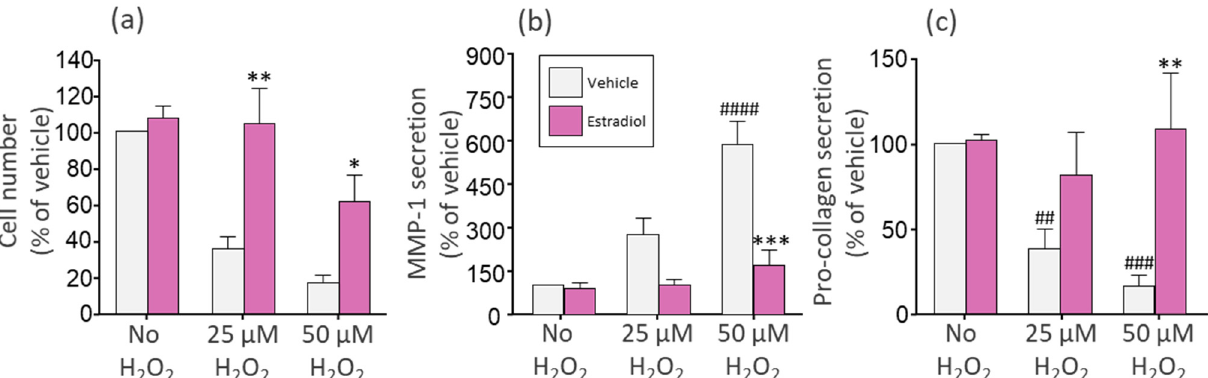
Figure 4. Estradiol protects fibroblasts from H 2 O 2 -induced cell damage. NHDF cells were pre-incubated for 24 h with 10 nM estradiol. Then, H 2 O 2 was added at the indicated concentrations for an additional 24 h. The cell number ( a ), and secretion of MMP-1 ( b ) and pro-collagen 1a1 ( c ), were determined as described in the legend of Figure 1. Results are presented as a percent of the values without H 2 O 2 . Y-axis scales: 100% of the cell number was 40,040 ± 3011 cells/well; 100% of the MMP-1 secretion was 54.3 ± 7.6 pmol per 1000 cells; 100% of the pro-collagen secretion was 32.7 ± 16.7 pmol per 1000 cells. Values are the means ± SD of 2–7 experiments, each performed in triplicate. ## p < 0.01, ### p < 0.001, #### p < 0.0001, significant difference between the vehicle with and without H 2 O 2 . * p < 0.05, ** p < 0.01, *** p < 0.001, significant difference between the vehicle and other treatments in the presence of H 2 O 2 .